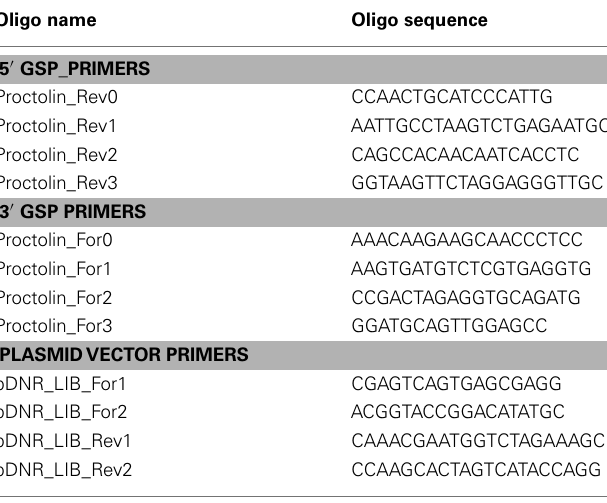
Table 1 | Gene-specific primers (GSPs) for the R . prolixus proctolin and plasmid vector